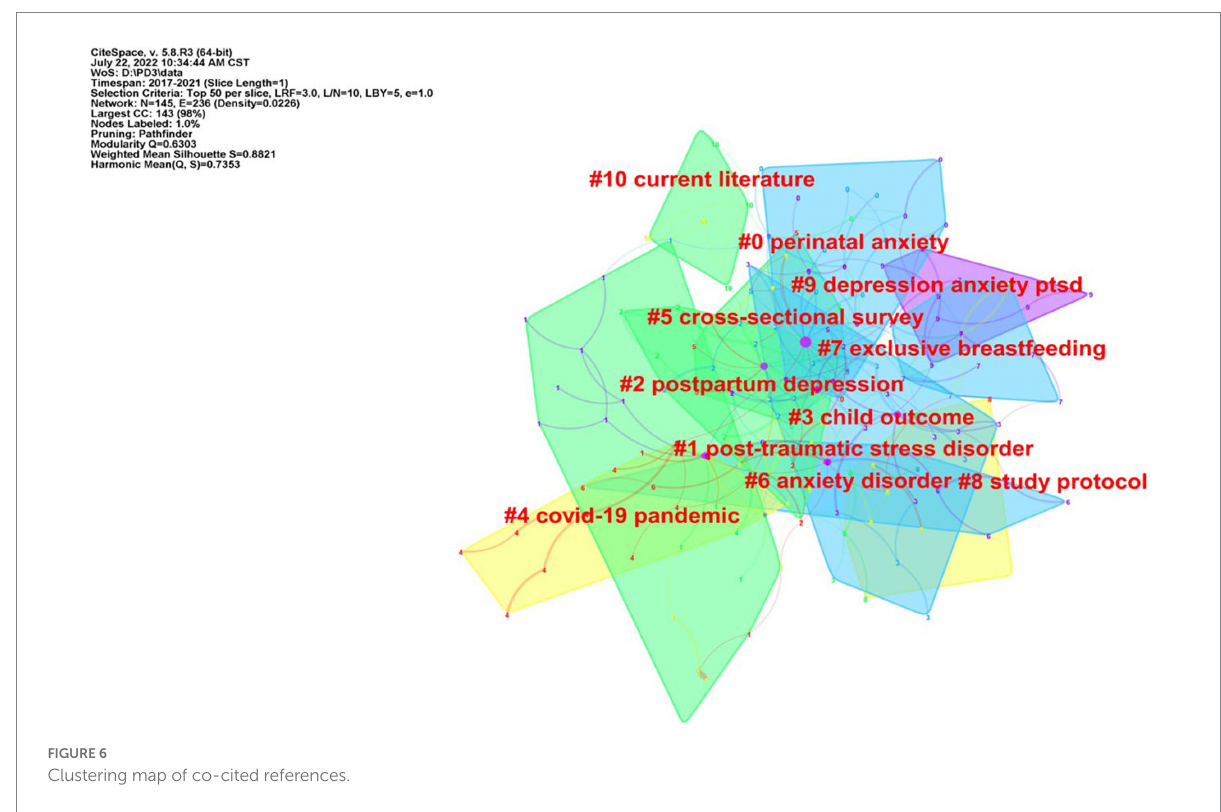
FIGURE 6 Clustering map of co-cited references.